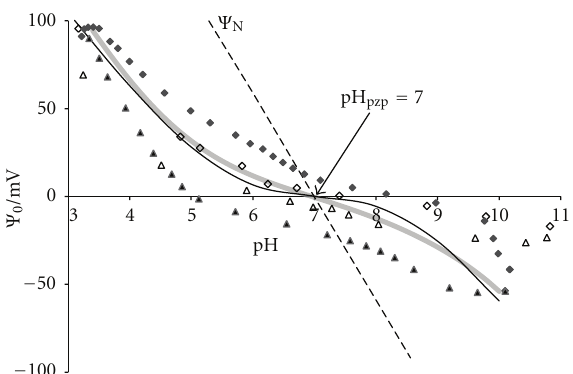
Figure 5: Surface potential of polycrystalline hematite in aqueous NaClO 4 solution ( c = 10 − 3 mol dm − 3 ) at 25.0 ◦ C. Nonequilibrium data are taken from Figure 3 ( (cid:2) , (cid:3) ). Data for partially equilibrated systems (ultrasound) are taken from Figure 4 ( ♦ , (cid:5) ). Evaluated equilibrium values are denoted with the thick gray band. The solid line was calculated on the basis of the surface complexation model, as demonstrated in the next paragraph. The Nernstian potential Ψ N is denoted with the dashed